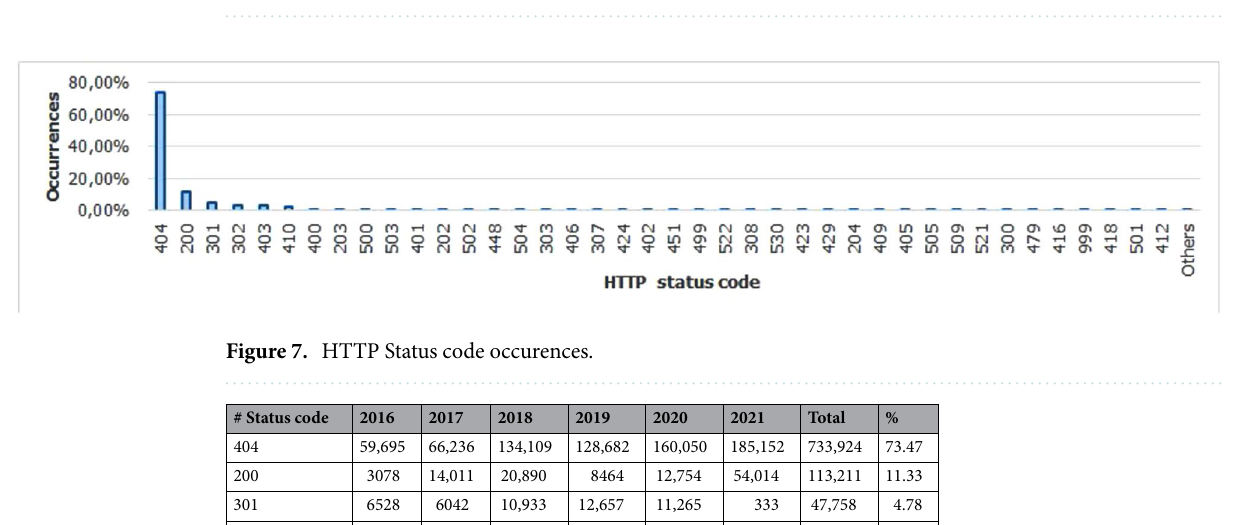
Figure 6. Phishing report by month over 2016 to 2021.